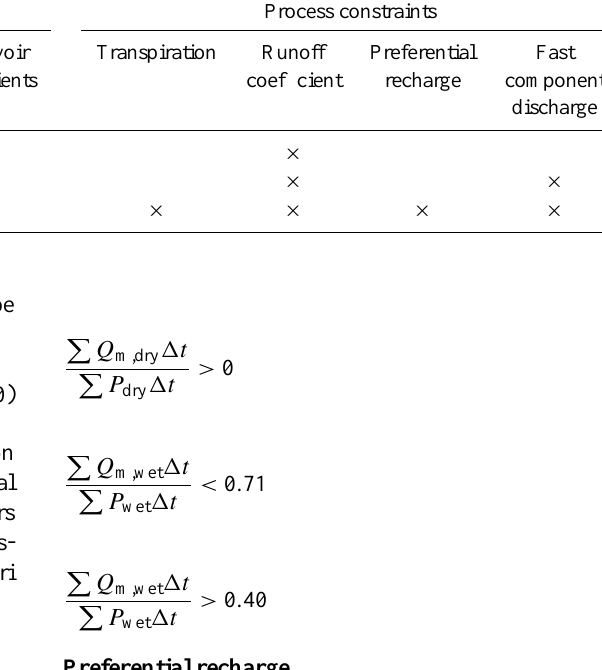
Lag Soil Runoff Fast functions moisture coefficients